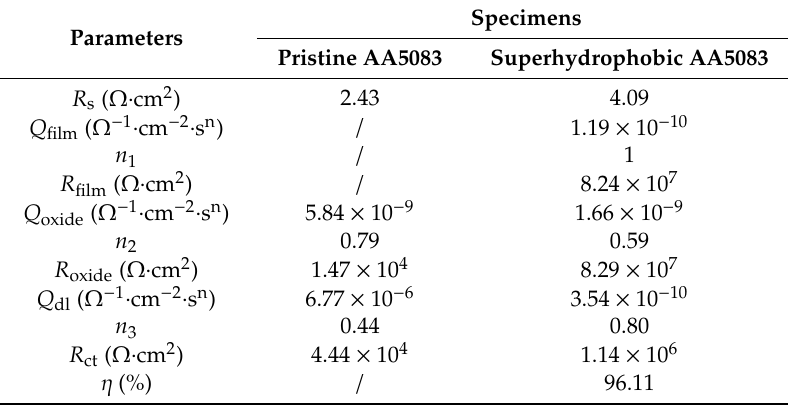
Table 1. The electrochemical parameters of simulated pristine AA5083 and superhydrophobic AA5083 surfaces in 3.5 wt.% NaCl aqueous solution.